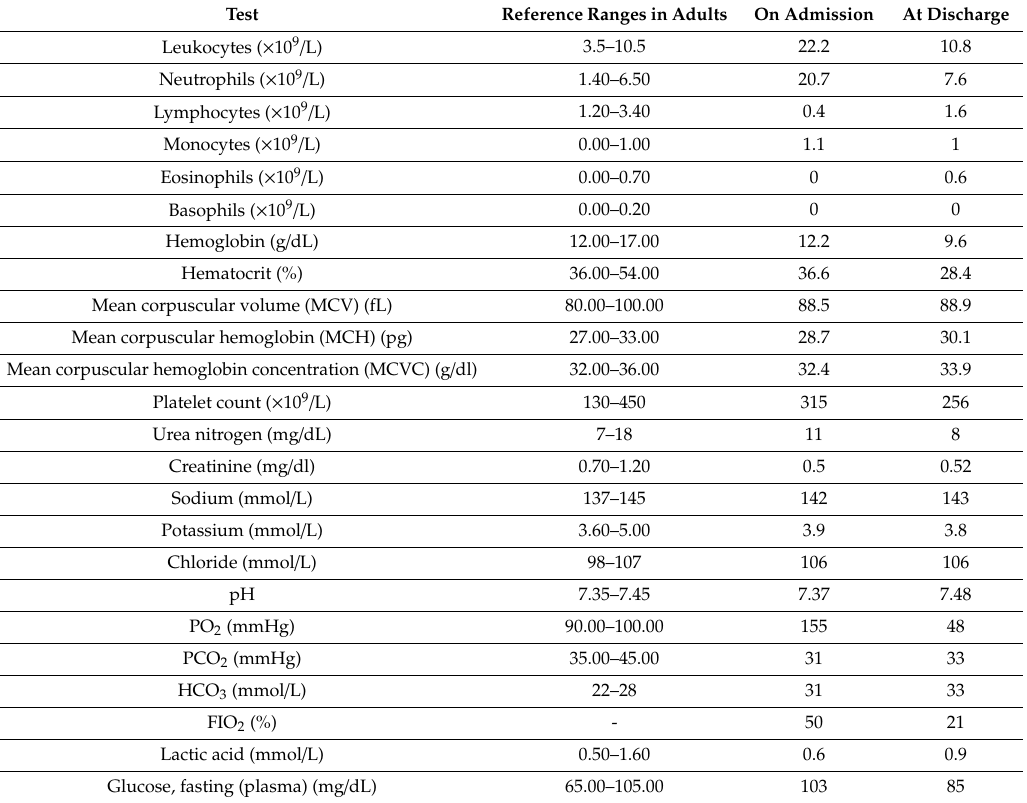
Table 1. Clinical laboratory test